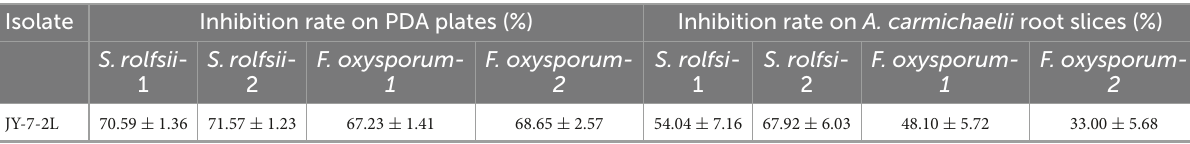
TABLE 1 Antagonistic activity of JY-7-2L against Sclerotium rolfsii and Fusarium oxysporum in vitro and on Aconitum carmichaelii root slices by dual culture method. Isolate Inhibition rate on PDA plates (%) Inhibition rate on A. carmichaelii root slices (%)